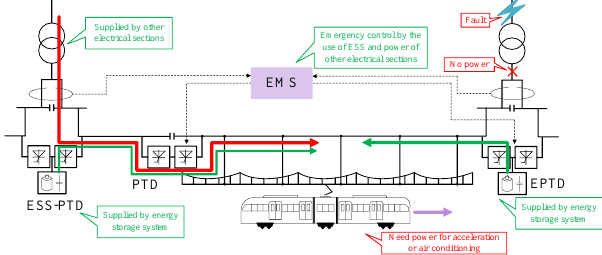
Figure 9. Emergency control based on the modified system.